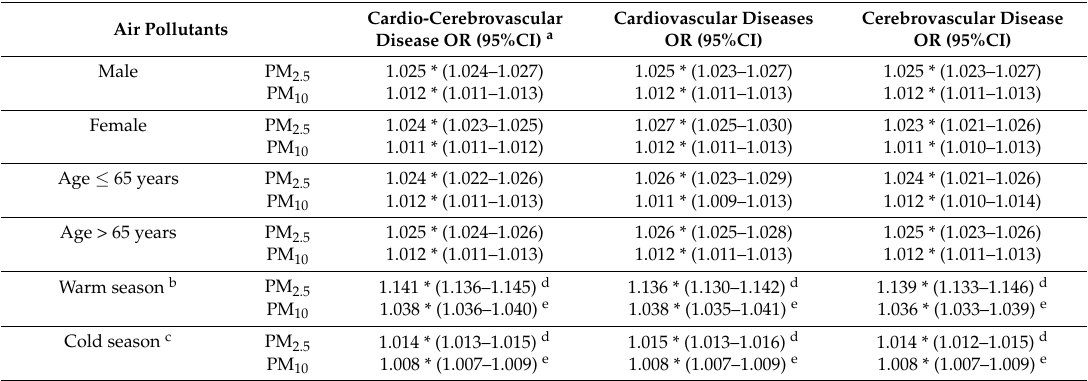
Table 5. The association of cardio-cerebrovascular disease mortality with 10 µ g/m 3 increase of PM 2.5 /PM 10 concentrations in different stratifications.